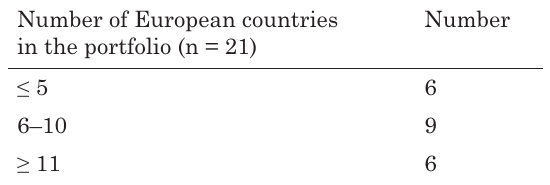
Table 6. Amount of different countries